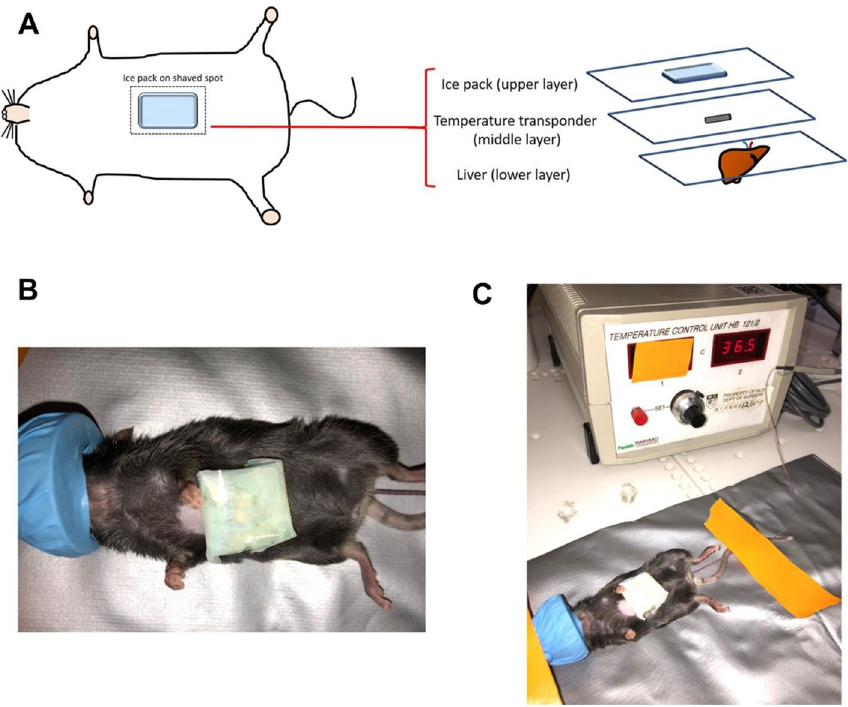
Figure 1. In vivo set-up for targeted cooling of the liver. ( A ) A pictorial representation demonstrates the position of the temperature transponder and the ice pack with respect to the liver. The illustration is not drawn to scale. ( B ) Close-up photograph and ( C ) a wide shot of the actual set-up in mice. Pulsed cooling of the liver is performed with ice pack under isoflurane anesthesia and a rectal probe is used to measure core body temperature of the mice. Throughout the cooling cycle, the mice were placed on a 37 °C heating pad to maintain core body temperature within normal